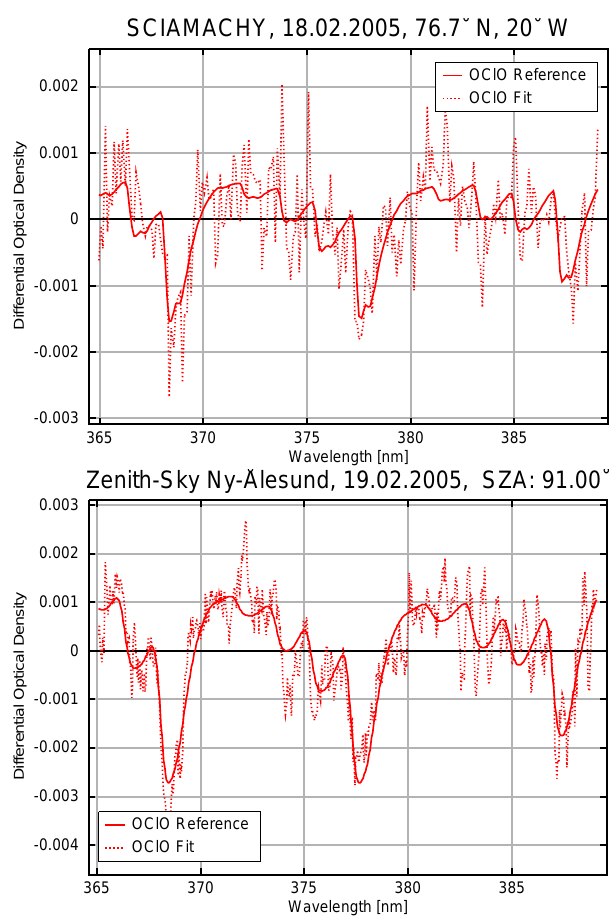
Fig. 2. Example of the OClO retrieval fit for SCIAMACHY (top panel) and for ground-based measurement for Ny- ˚Alesund (bottom